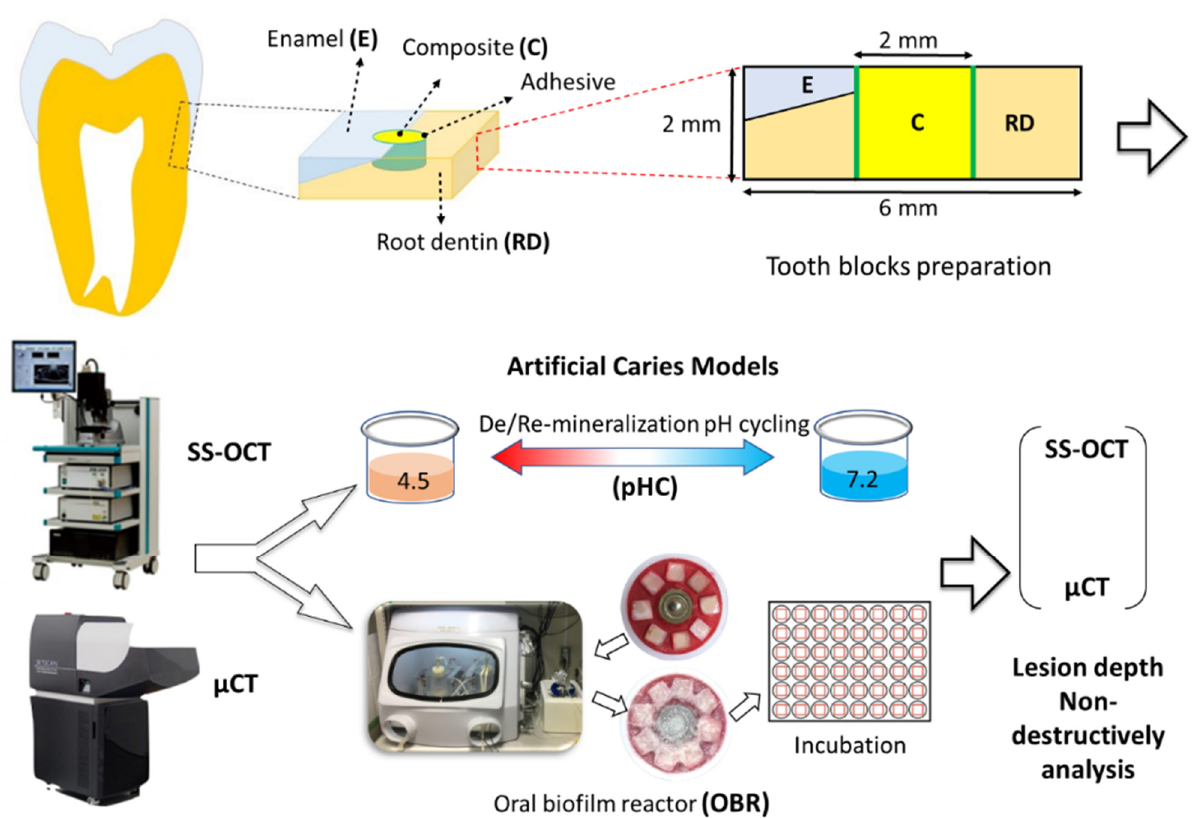
Figure 1. Schematic view of specimen preparation and study design for the anti-demineralization test. Thirty-two extracted human teeth were used in this study. Sixty-four cubical blocks (6 mm × 6 mm × 2 mm) were prepared from the enamel–root dentin junction. After adhesive (Single Bond Universal or FL Bond II) application and composite (Beautifil II or